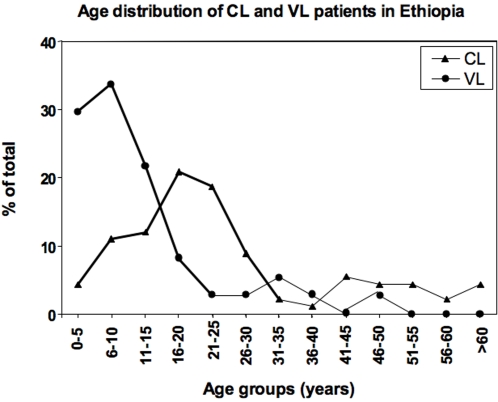
Age distribution of visceral and cutaneous leishmaniasis.The age distribution of patients suffering from visceral (n = 37, circle) or cutaneous (n = 91, triangle) leishmaniasis was determined in endemic areas of Ethiopia.